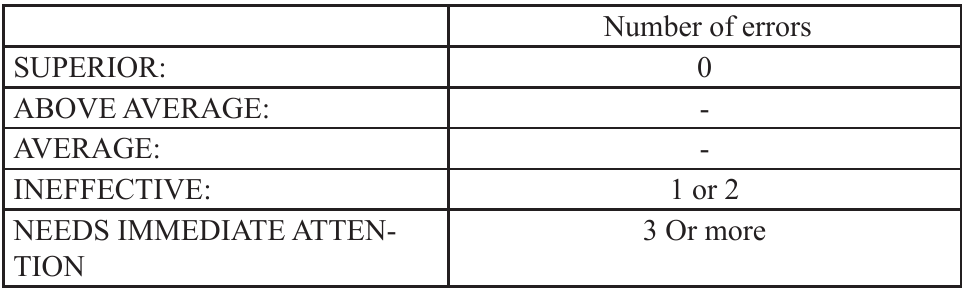
Table 4: The norms obtained for Colour Discrimination with the use of the Farnsworth D-15 colour vision test.